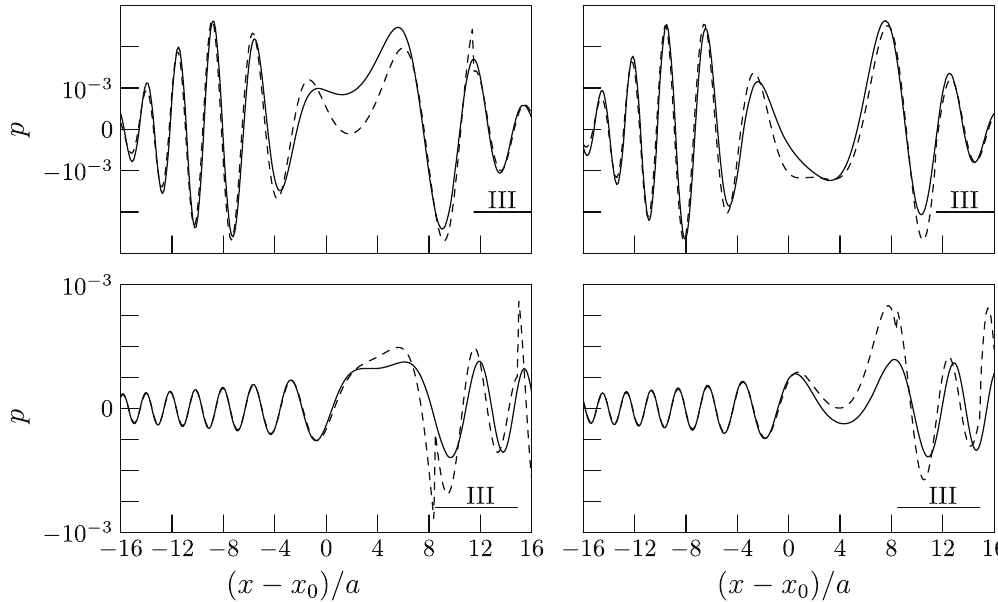
Figure 5. Acoustic potential above and below source; left-hand column: real part; right-hand column: imaginary part; solid line: numerical; dashed line: approximation. Top row: fi eld above source and plate; bottom row: fi eld below source and